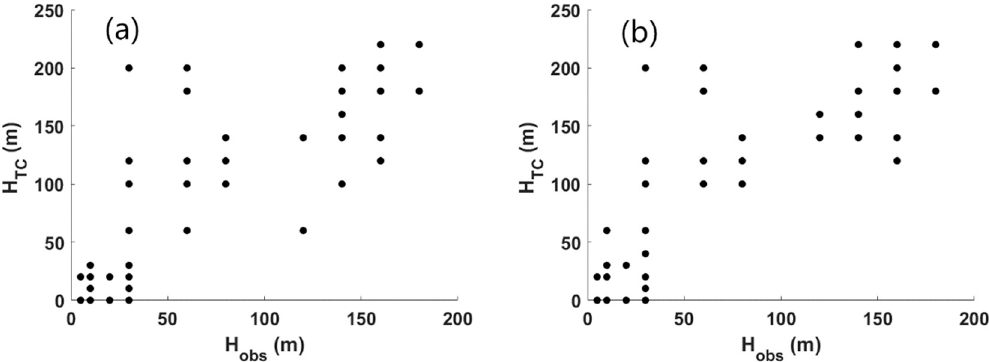
Figure 6. Scatterplots of observations of fog thickness against the estimation of fog thickness by temperature convergence (TC) method using in Equation (17), with ( a ) threshold value is set to 1.2 K, ( b ) threshold value during fog development phase and dissipation phase is set to 1.2 K and 1 K, respectively.